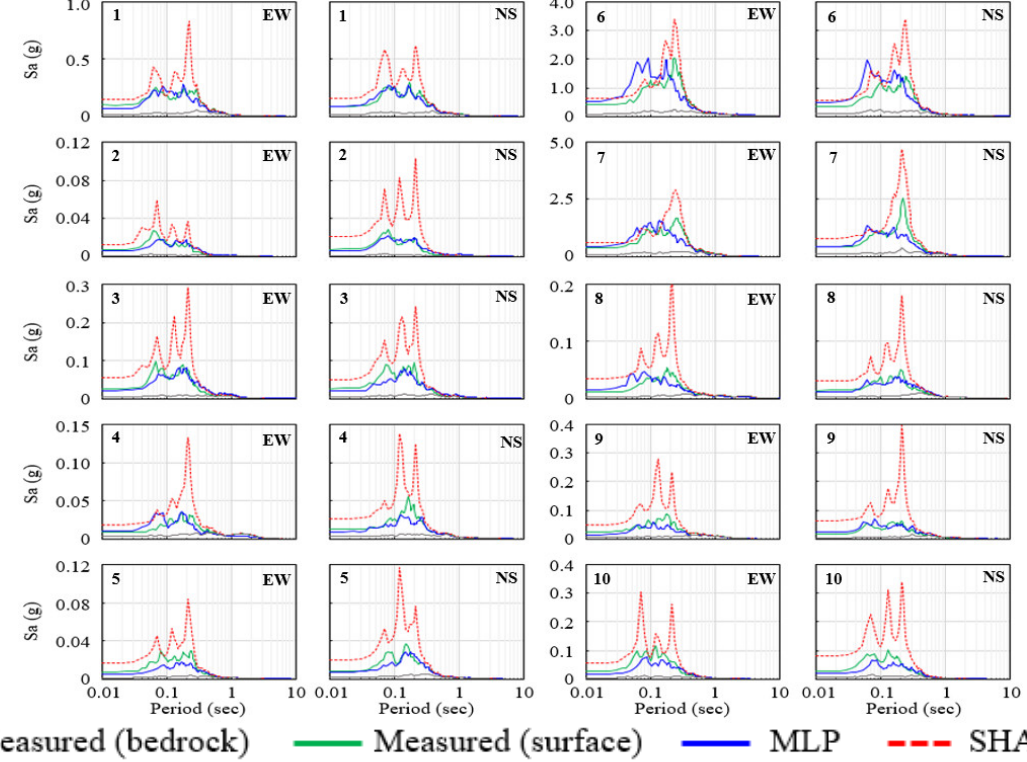
Figure 11. Measured, predicted, and computed response spectra at IWTH21 for east–west and north–south directions.